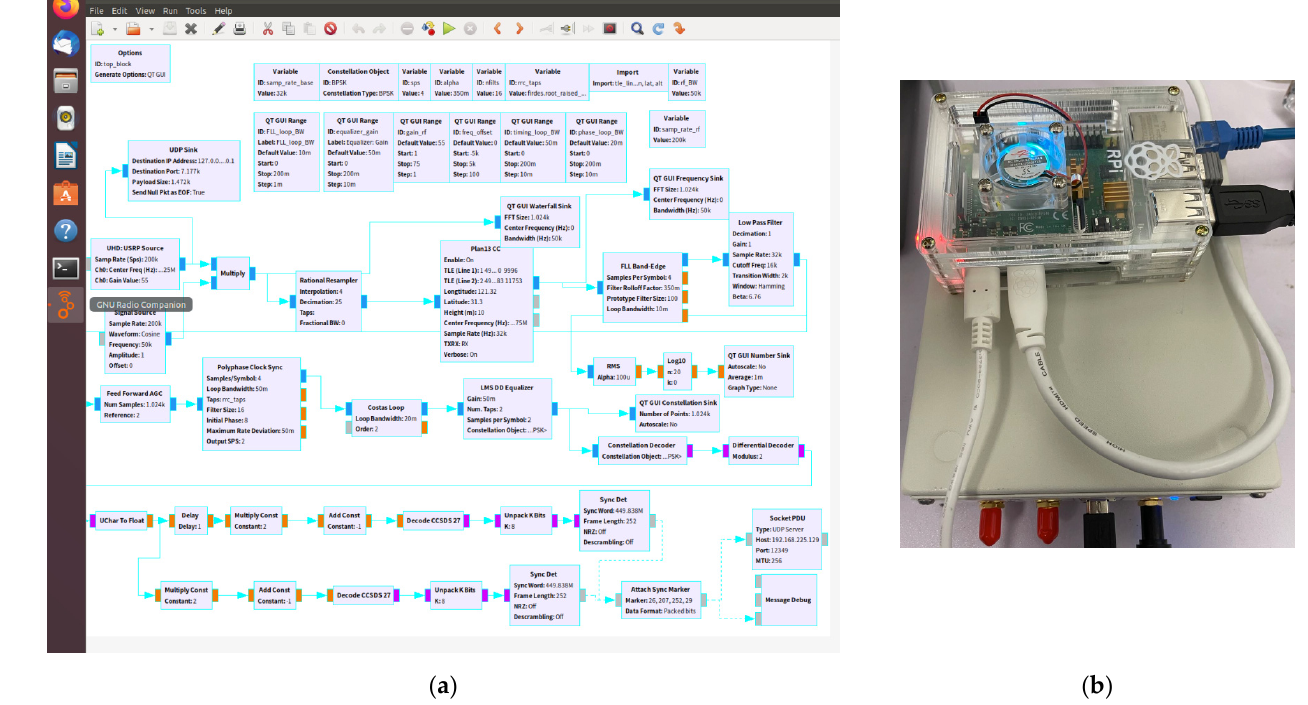
Figure 14. ( a ) Demodulation flow; ( b ) digital frontend and digital baseband modules.